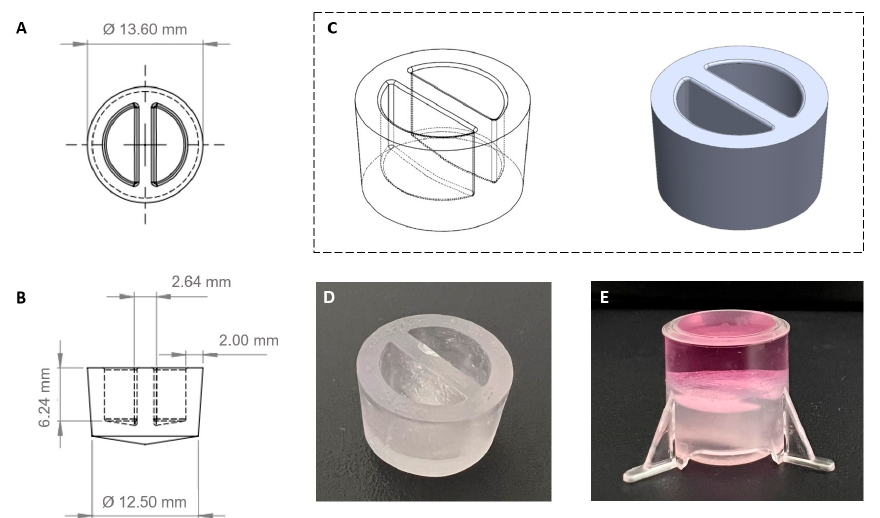
Figure 2. Custom-designed 3D-printed cap. The design sketches of the cap are: top view ( A ), front view ( B ), and 3D view ( C ). The dimensions of this cap ( D ) were determined to fit into the insert perfectly to safely confine the medium within the insert during the macrophage adherence procedure ( E ).